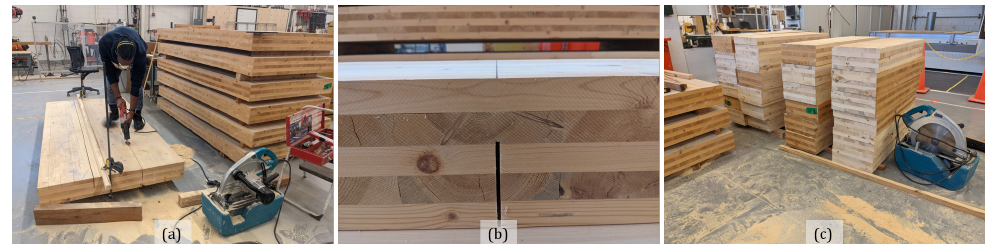
Figure 1. CLT Panel Specimen Processing: ( a ) cutting in progress, ( b ) partial cut with circular saw, ( c ) completed test specimen.